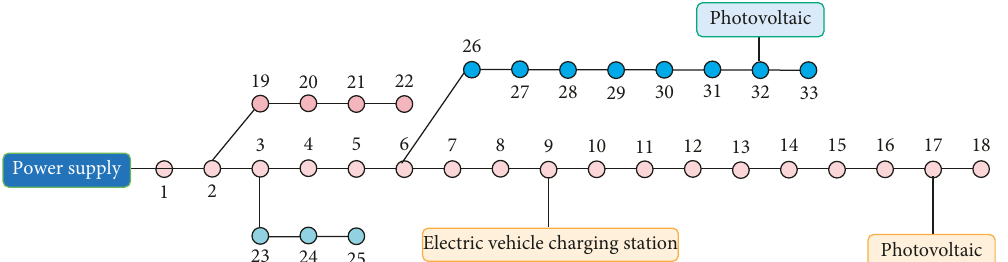
Figure 4: Topological structure of the 33-node distribution network after transformation.